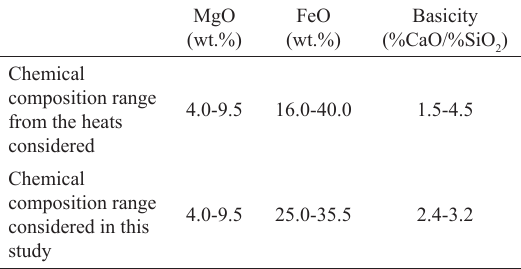
Table 1: Range of chemical composition of slag from the heats.